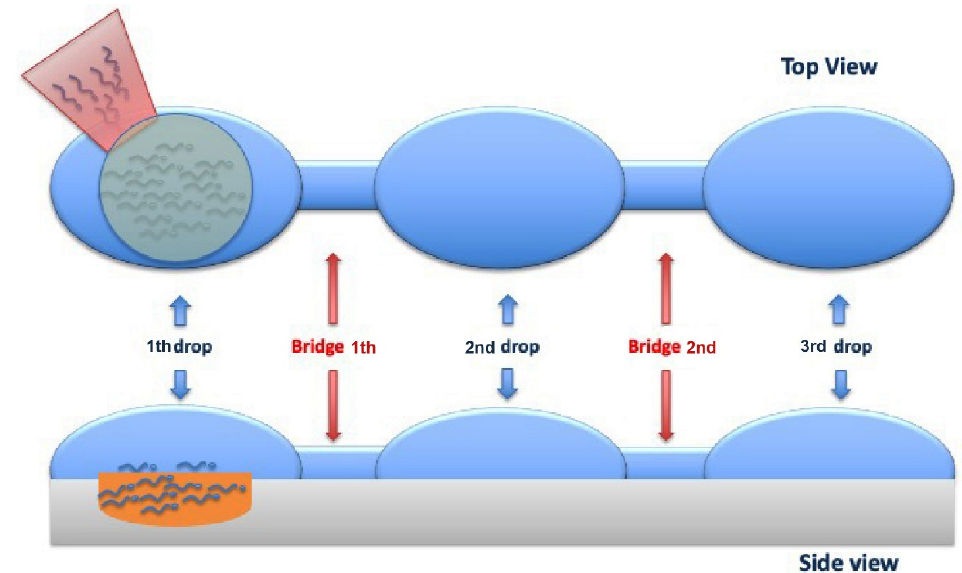
Figure 11. Top and Side viewing of the sperm cells horizontal migration from the first drop (where the cells are added) to the third drop (where the sperm cells are aspirated) through 2 bridges that link them.